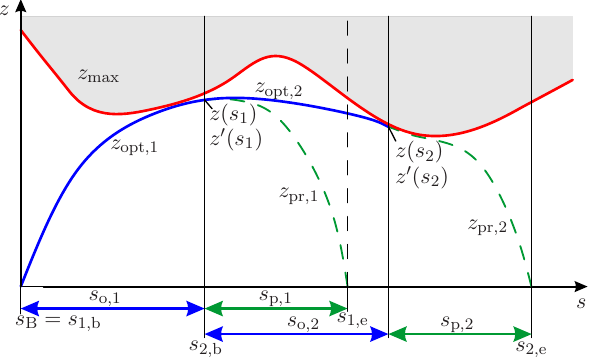
Figure 2. Solution strategy: successive dynamic programming